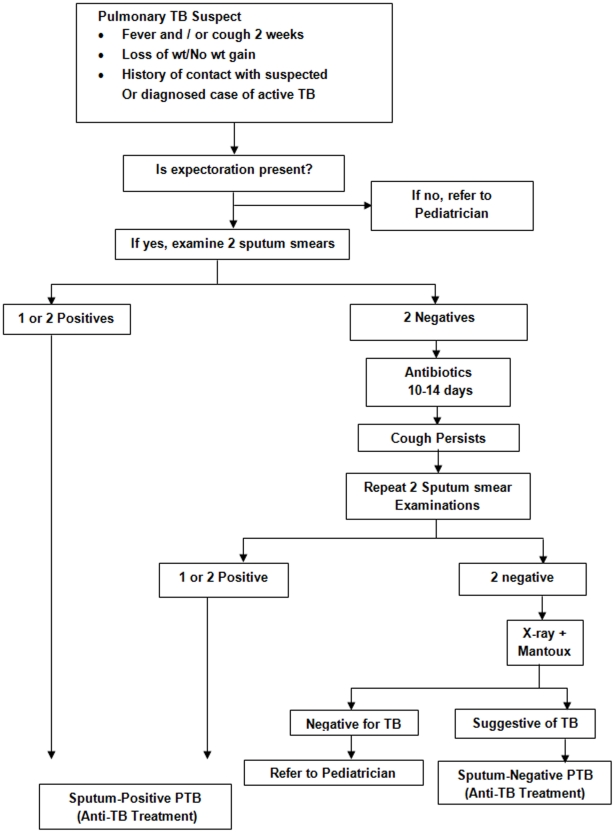
Diagnostic algorithm for paediatric pulmonary TB.